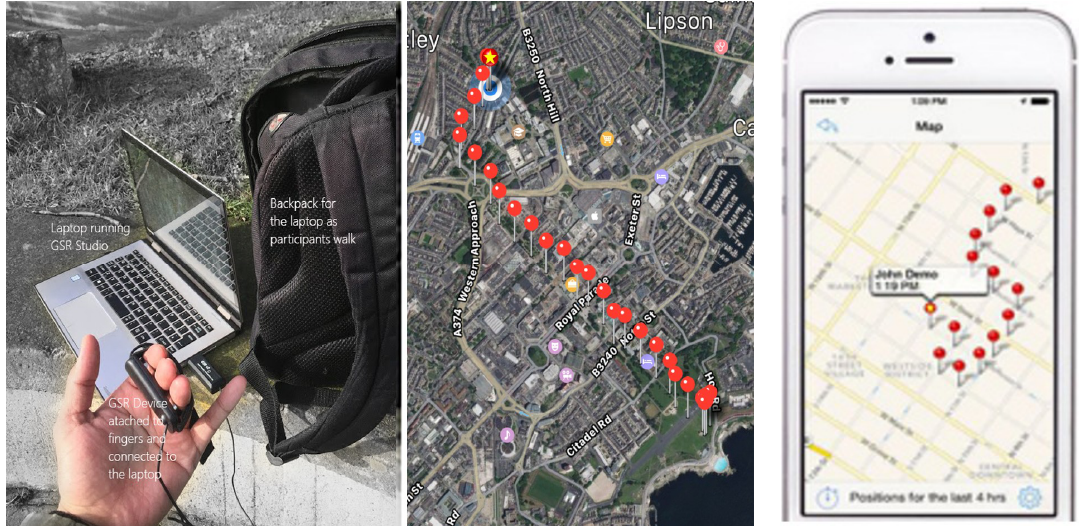
Figure 4. Experiment set-up consisting of a finger mounted GSR device, a laptop, and a backpack linked to a GPS Phone Tracker App that was used to track participant’s location at 1-min intervals during the walk.